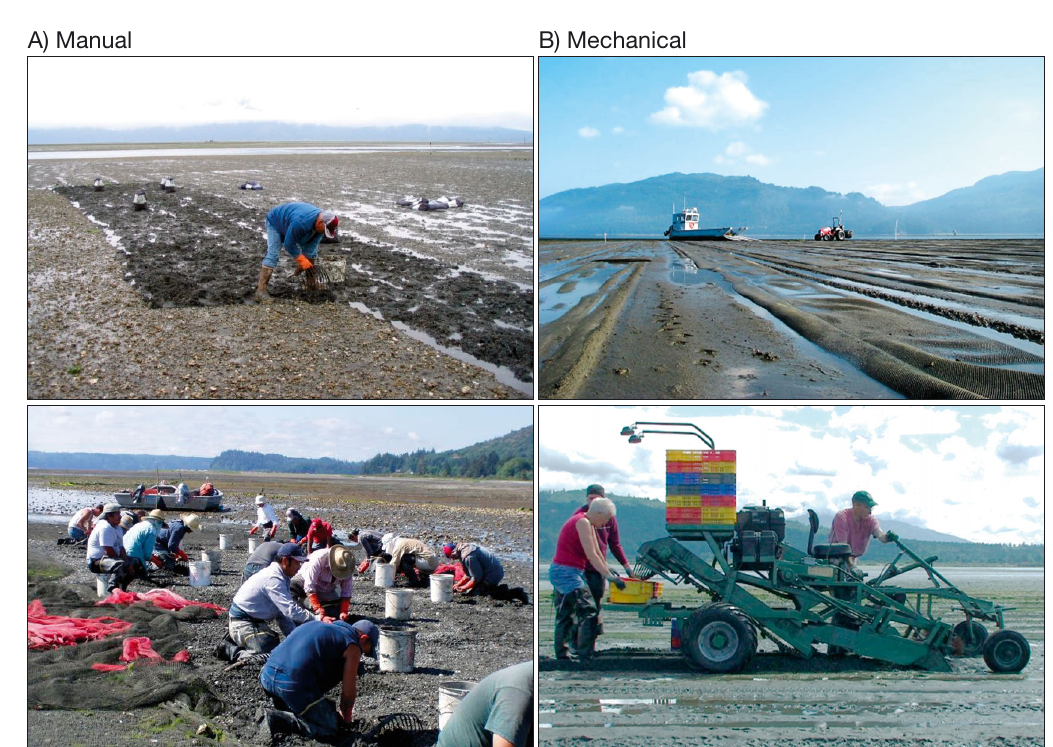
Fig. 2. (A) Manual versus (B) mechanical intertidal bottom culture of Manila clams in Samish Bay (Photo courtesy B.